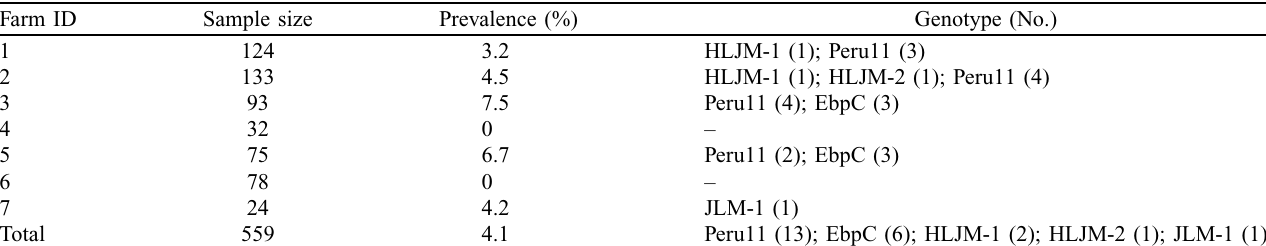
Table 2. Distribution of Enterocytozoon bieneusi genotypes on different farms. Farm ID